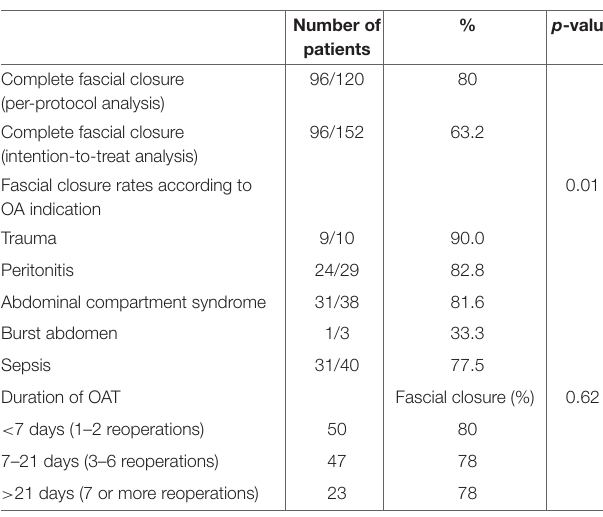
TABLE 2 | Treatment